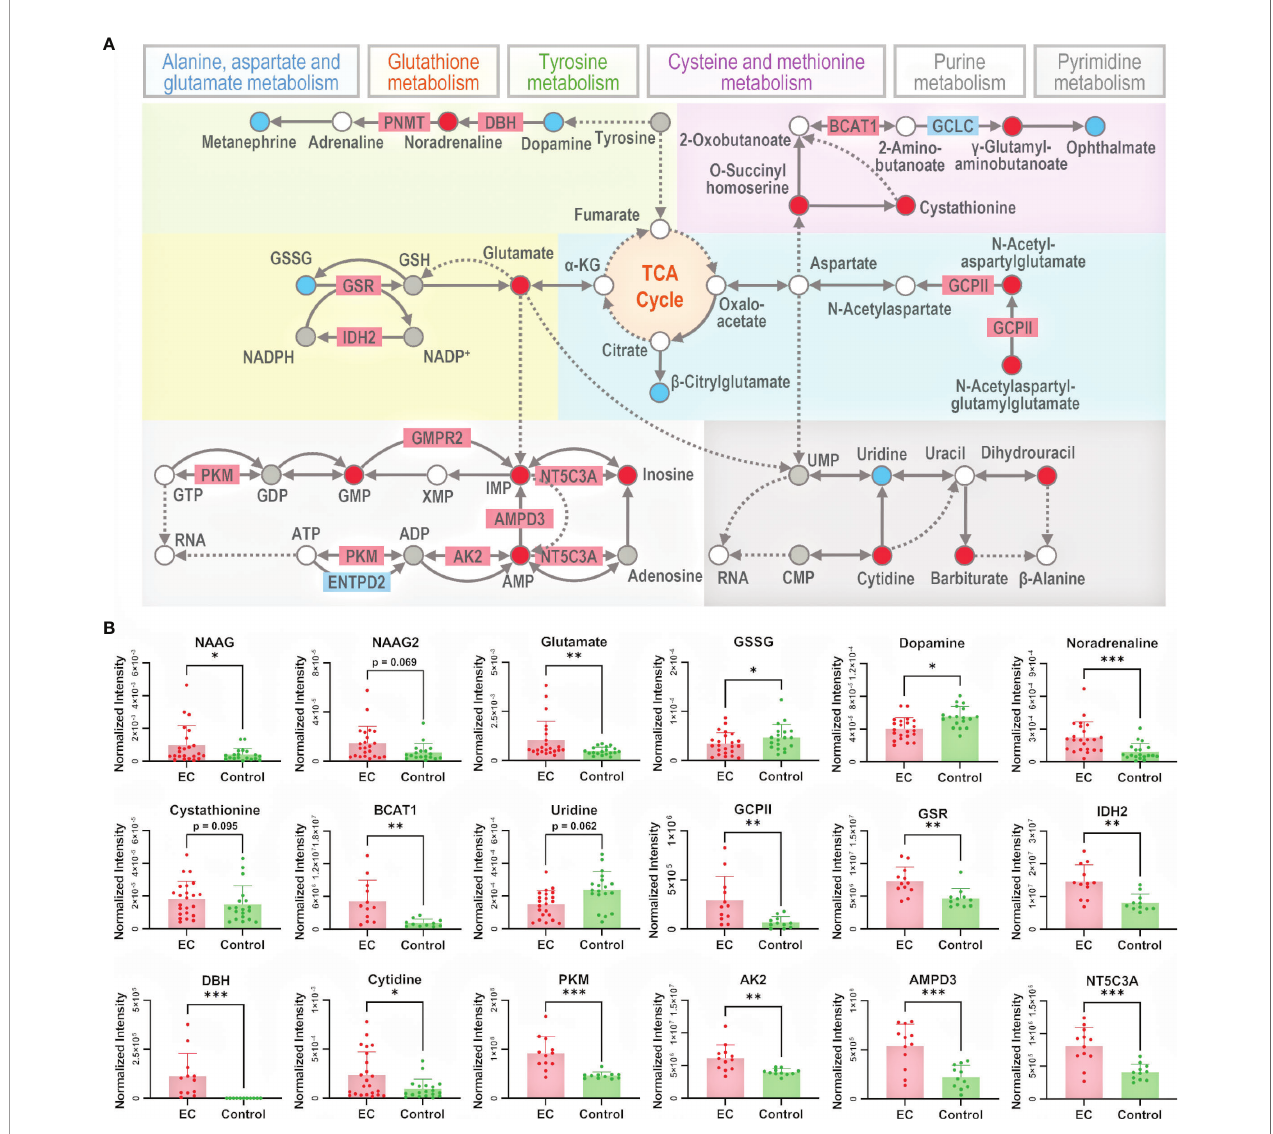
FIGURE 4 | Illustration of the signi fi cant pathways and differential metabolites and proteins relating to energy metabolism connected to the TCA cycle. (A) Pathway overview of amino acid metabolism and nucleotide metabolism. Circles represent metabolites and rectangles represent proteins. Red- fi lled circles or rectangles indicate that the metabolites or proteins are upregulated in the EC group compared to the control group, and blue- fi lled ones indicate downregulation. Gray- fi lled circles represent the identi fi ed but not signi fi cantly changed metabolites, and the white- fi lled ones represent the unidenti fi ed metabolites to better connect and explain the pathways. Solid lines indicate direct reactions between metabolites, while dashed lines indicate multi-step reactions. (B) Normalized intensity of metabolites and proteins involved in the illustrated pathways. NAAG, NAAG2, GSSG, GCPII, GSR, IDH2, DBH, BCAT1, PKM, AK2, AMPD3, and NT5C3A represent N-acetylaspartylglutamate, N-acetylaspartylglutamylglutamate, glutathione disul fi de, glutamate carboxypeptidase II, glutathione-disul fi de reductase, isocitrate dehydrogenase 2, dopamine b -hydroxylase, branched chain amino acid transaminase 1, pyruvate kinase M1/2, adenylate kinase 2, adenosine monophosphate deaminase 3, and cytosolic 5 ’ -nucleotidase 3A, respectively. Error bars represent the standard deviation. “ * ” , “ ** ” , and “ *** ” indicate p -values smaller than 0.05, 0.01, and 0.001, respectively. See also Supplementary Figures 8 , 9 for other signi fi cant metabolites and